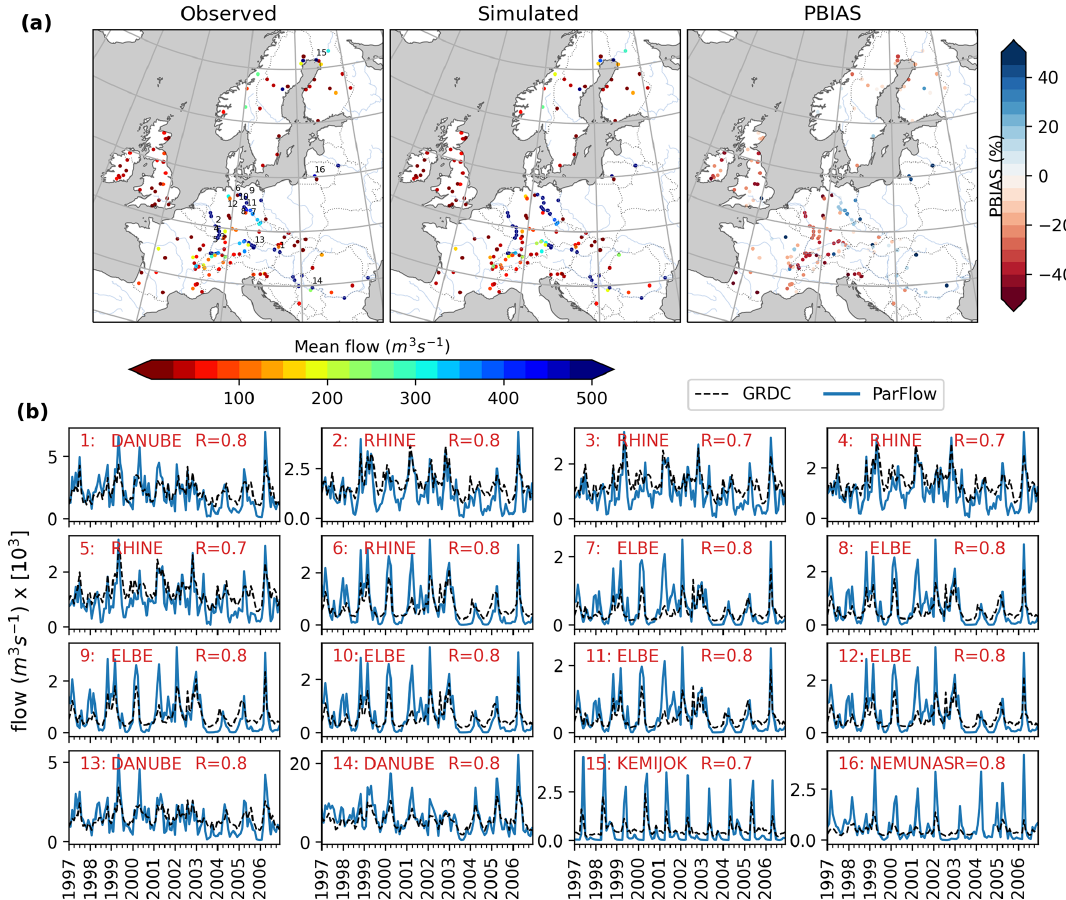
Figure 2. (a) Comparison of observed and simulated average discharge and the percentage bias in monthly discharge (PBIAS) for 176 gauging stations. (b) Comparison of time series of observed and simulated discharge for selected large rivers with drainage areas greater than 50000km 2 . Locations of selected gauges in (b) are indicated with corresponding numbers in the left panel of (a)